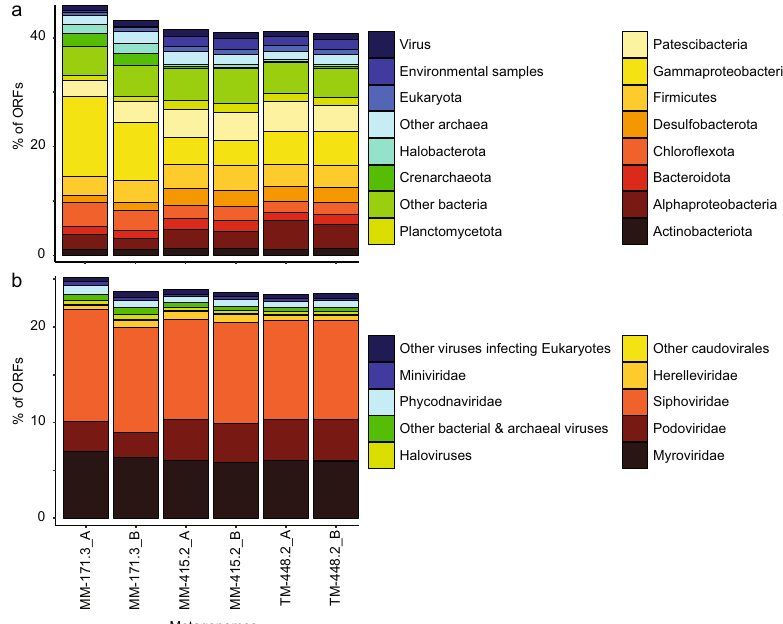
Fig. 4 Similarity of Äspö HRL viral ORFs to isolated viruses and cellular organisms. Percentage of Äspö HRL viral ORFs matching taxonomic units in a NCBI nr (June 2017) and b ViralDB (July 2019). Taxonomic units comprising <1% of the matches to NCBI nr and <0.2% of the matches to ViralDB are placed in ‘ others ’